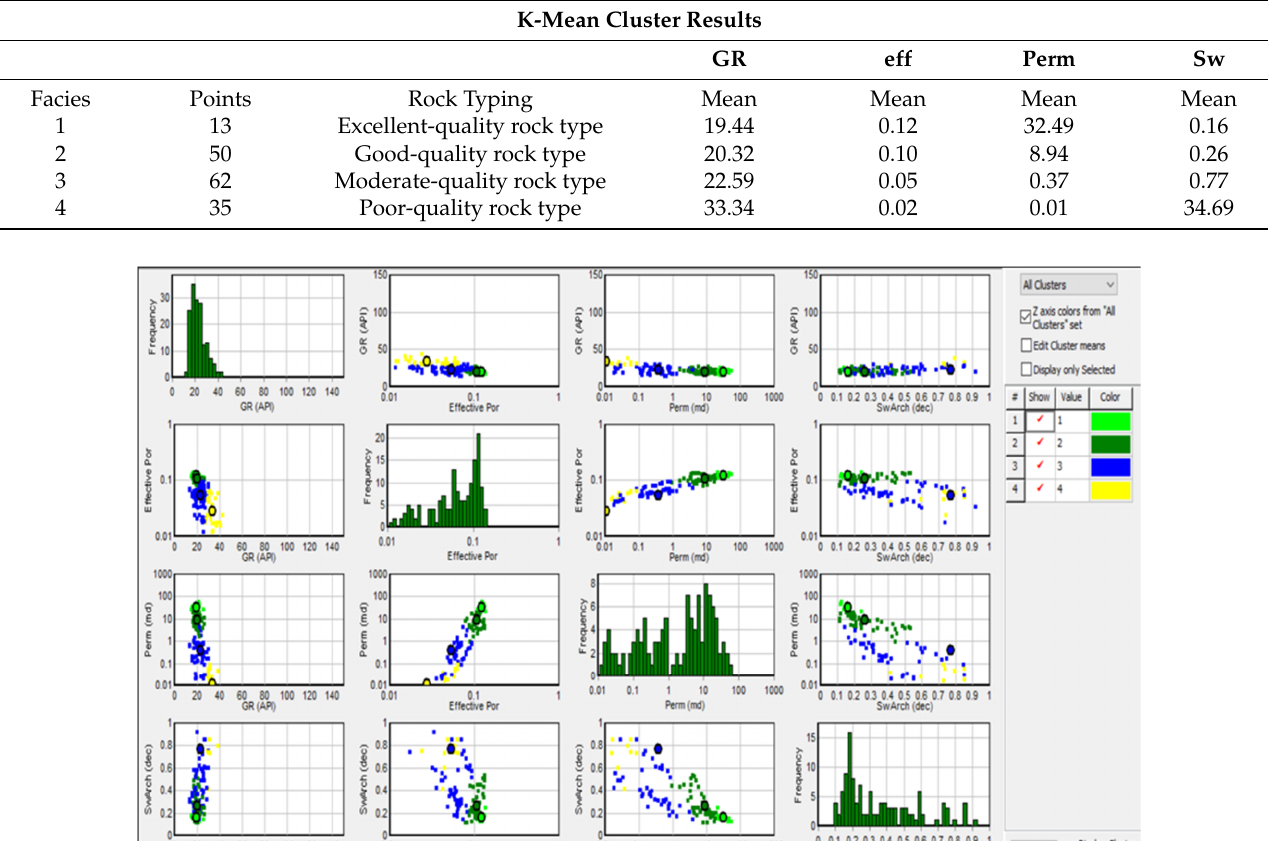
Table 2. The properties for groups of Facies.